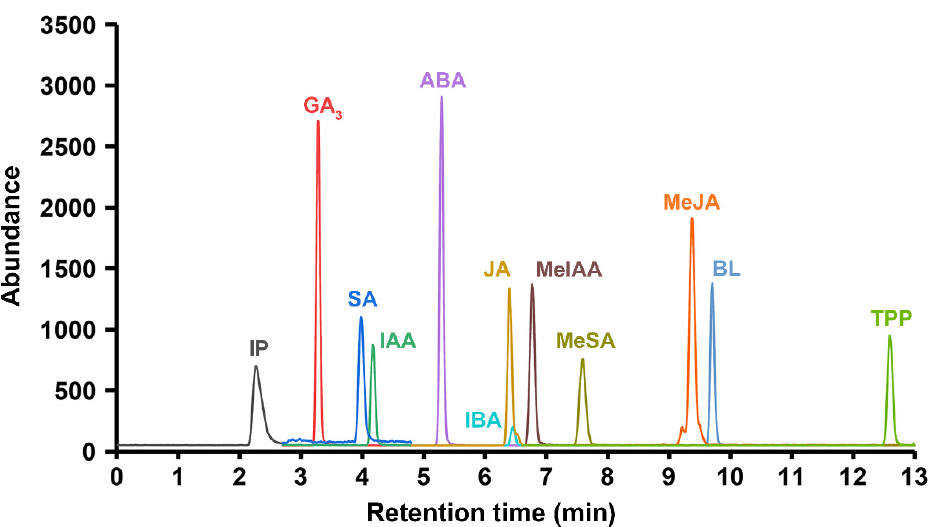
Figure 1. Chromatographic separation of 11 hormones and an internal standard. ABA, abscisic acid; BL, brassinolide; GA 3 , gibberellin A3; IAA, indole-3-acetic acid; IBA, indole-3-butyric acid; JA, jasmonic acid; MeIAA, methyl indole-3-acetate; MeJA, methyl jasmonate; MeSA, methyl salicylate; SA, salicylic acid; TPP, triphenyl phosphate; IP, N6-(2-isopentenyl) adenine.